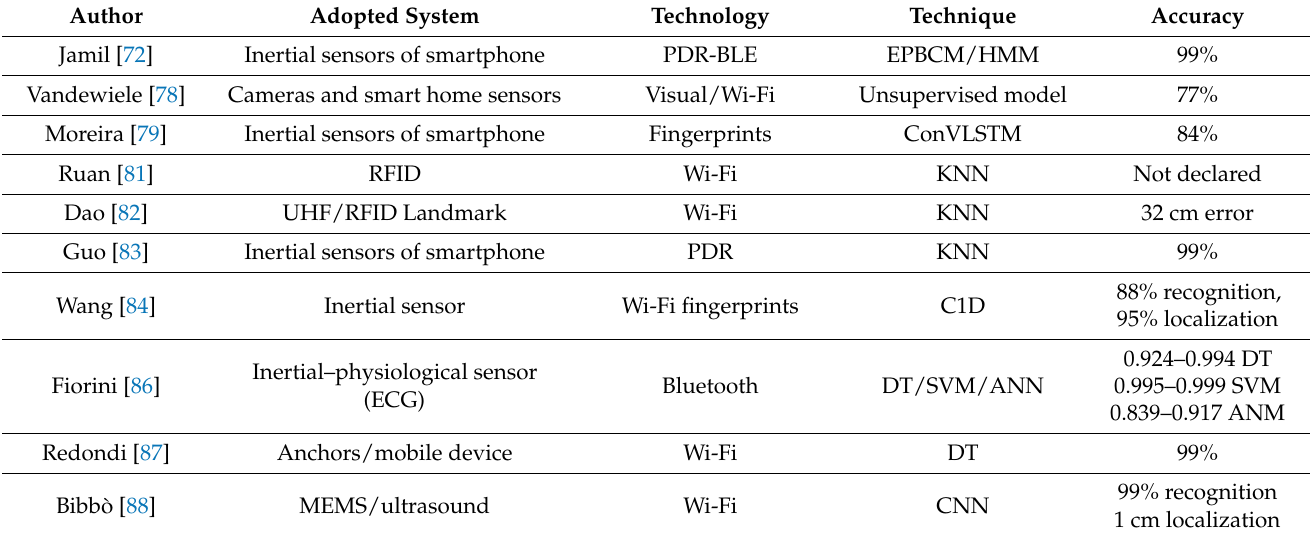
Table 5. Comparison of HAR-IPS systems.